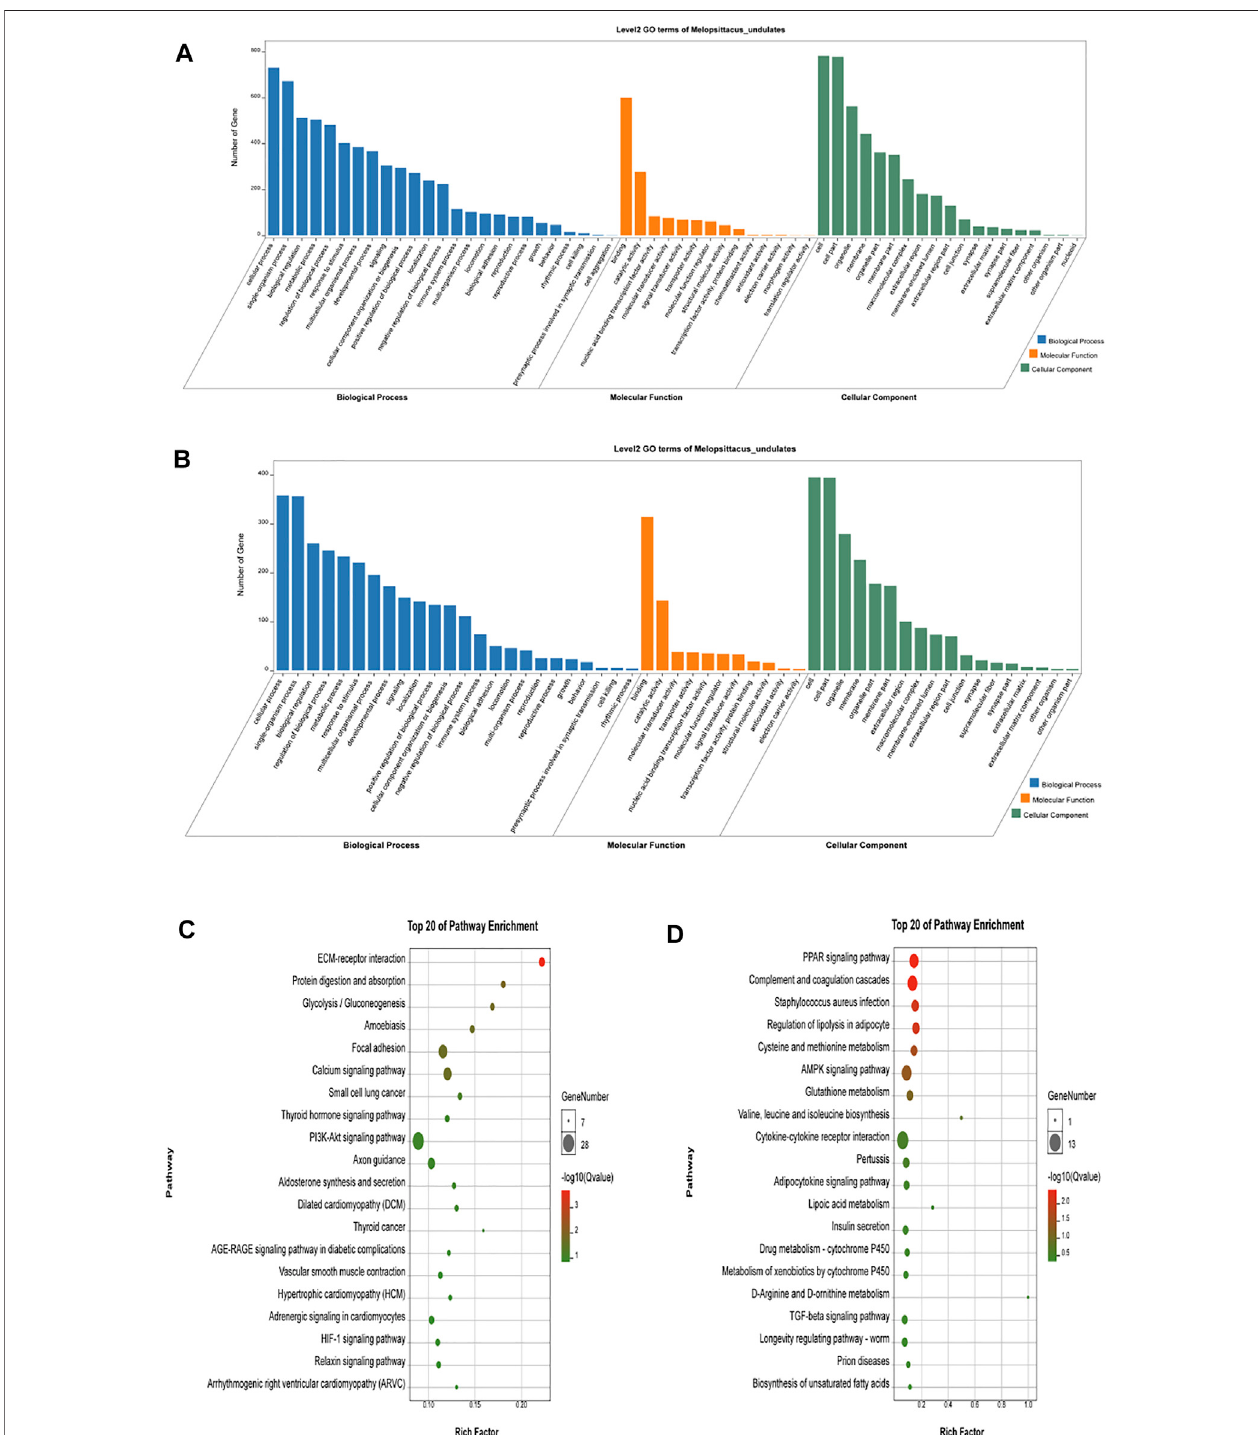
FIGURE3| Functionalanalysisofdifferentialgenes. (A,B) TheresultsofGoclusterenrichmentanalysisforup-regulatedanddown-regulated genes:thehorizontal axis represents the name of Go entry, and the vertical axis represents the number of genes enriched in the Go entry. (C,D) . Up-regulated genes and down-regulated geneswereanalyzedbyGoclusteranalysis.Thehorizontalaxisrepresentsthenameofthesamplegroup,andtheverticalaxisrepresentstheKEGGbiologicalpathway. Each point indicates the enrichment degree of the KEGG entry, and the closer the color to green, the higher the enrichment degree. The size of each dot indicates the number of genes enriched in the KEGG entry. The larger the dot, the more genes are enriched in the KEGG entry, and vice versa.